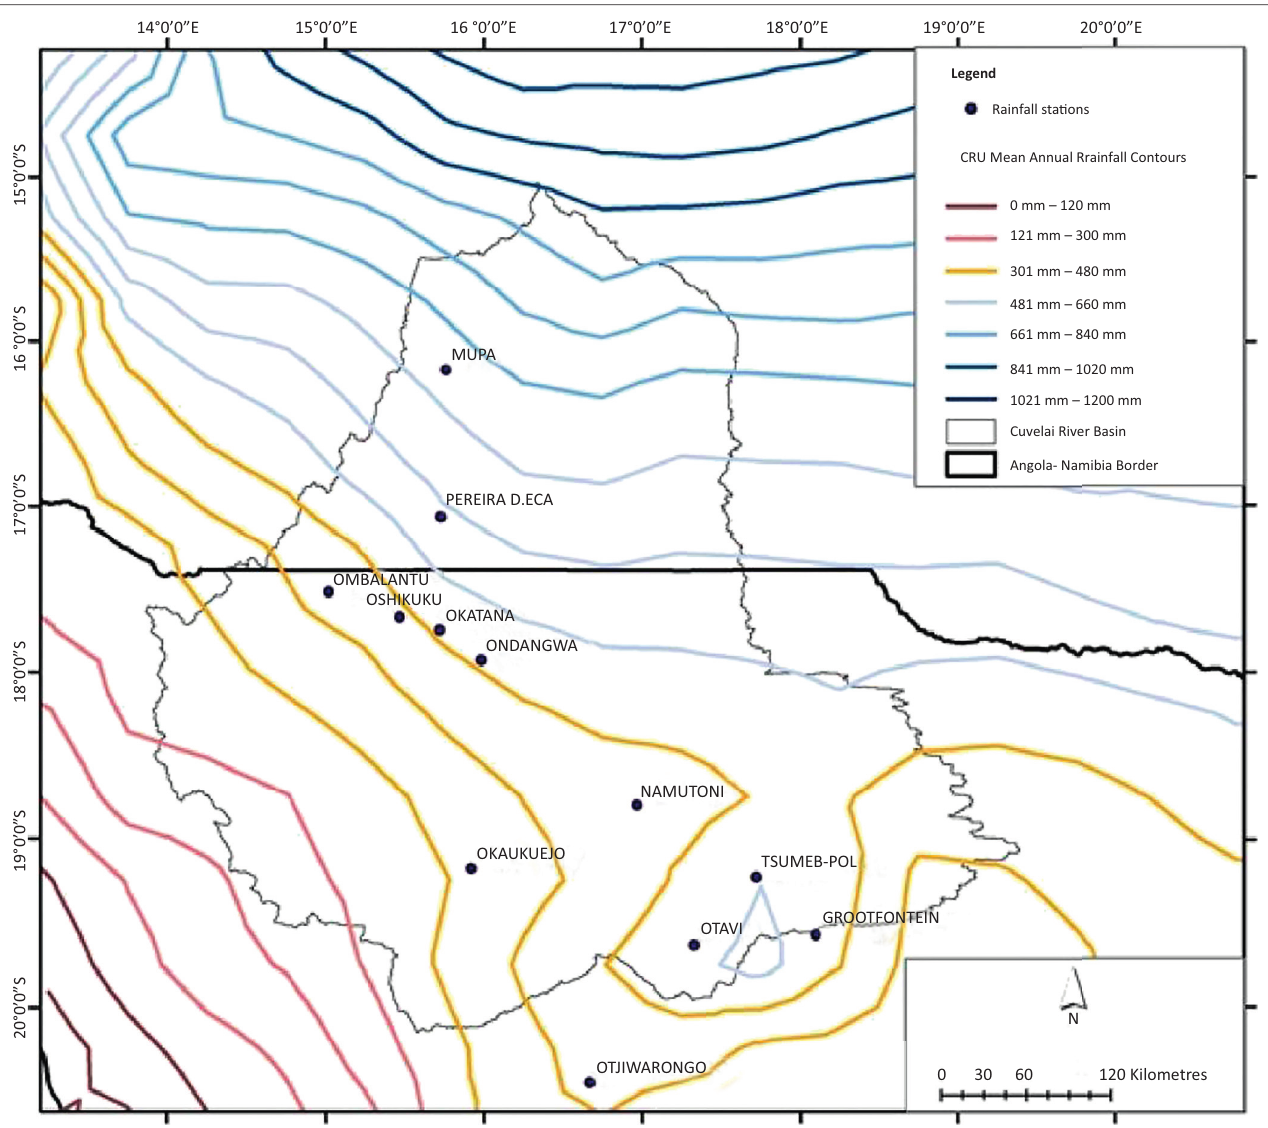
FIGURE 5: Mean annual rainfall for the CRB derived from CRU 3.21 data. The original data covered a period from 1901–2012 at a gridded spatial resolution of 0.5° and were converted into contours.